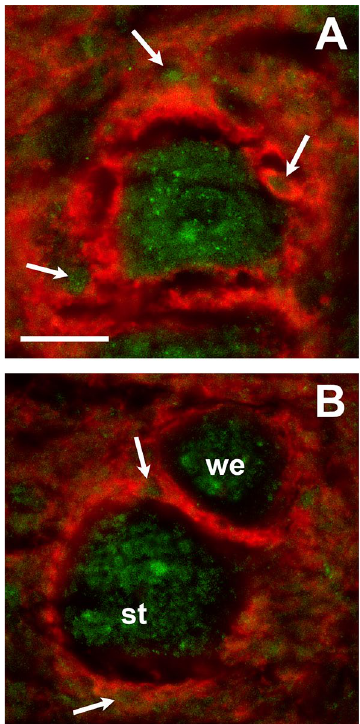
Figure 7. We recognized two morphological types of perineuronal nets in the extraocular motor nuclei of mice, shown with WFA fluorescent labelling. ( A ) Diffuse perineuronal nets spread 6–13 µm towards the neuropil without clear peripheral boundaries. Its spongy structure derives from numerous elliptical tunnel-like forms. Arrows demonstrate ECM tunnels of various diameters, presumably occupied by dendritic- and terminal axon segments. ( B ) Focal perineuronal nets expand max. 1–5 µm distance from the somata and clearly demarcate from the adjacent neuropil. Its compact ECM plates are interrupted by dotted or laminar CSPG accumulations which, in fewer number, also shape tunnel-like ECM sheaths (arrows). st: strongly immunoreactive focal PNN. we: weakly immunoreactive focal PNN. Scalebar: 20